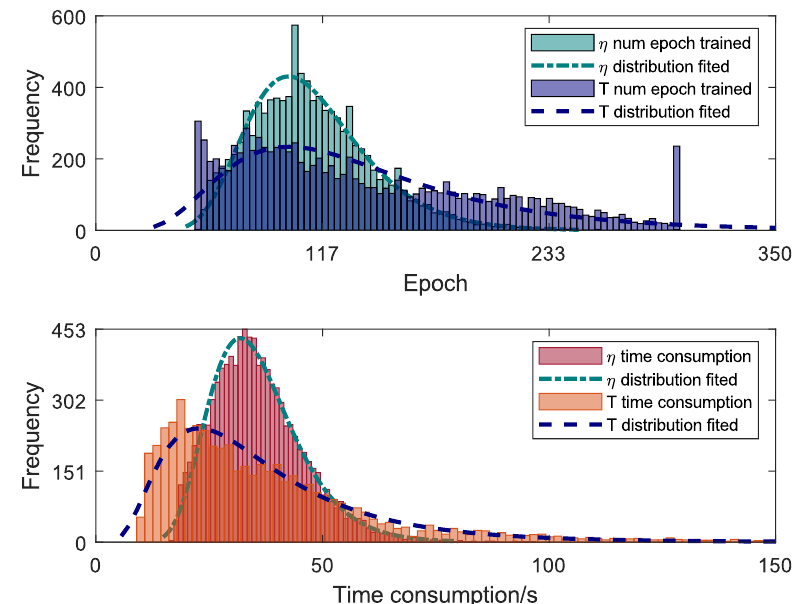
Figure 12. Trained epochs and training time of Monte Carlo training.